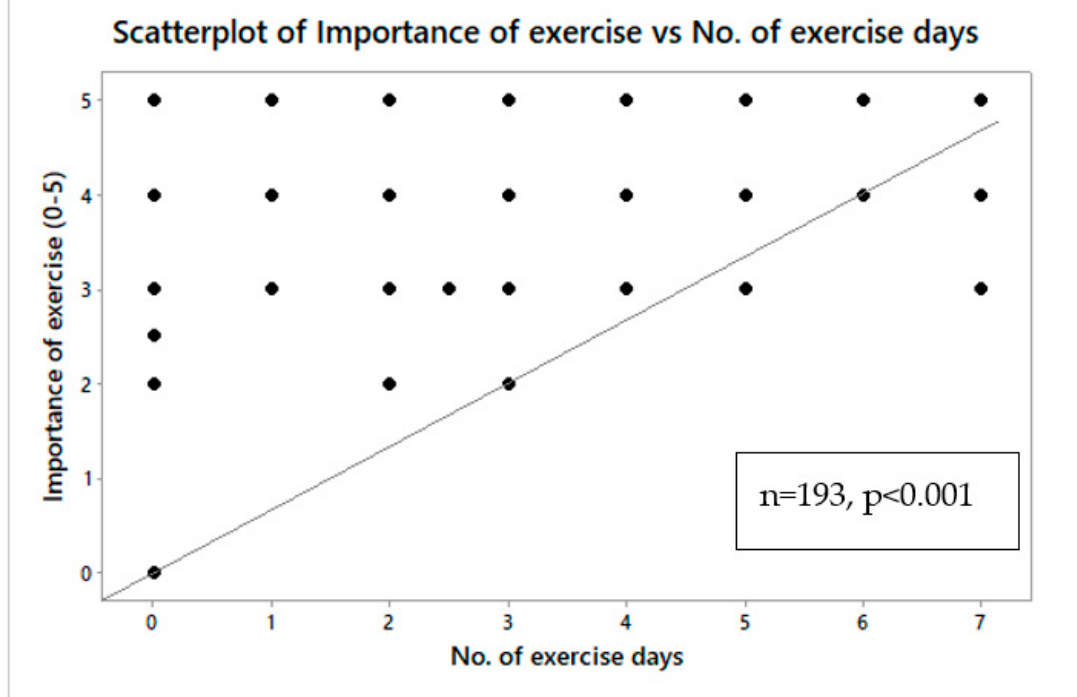
Figure 2. Scatterplot of the correlation of no. of exercise days and exercise importance. Total number of patients who responded = 193; each dot represents each patient who recorded the value for importance of exercise and no. of exercise days.